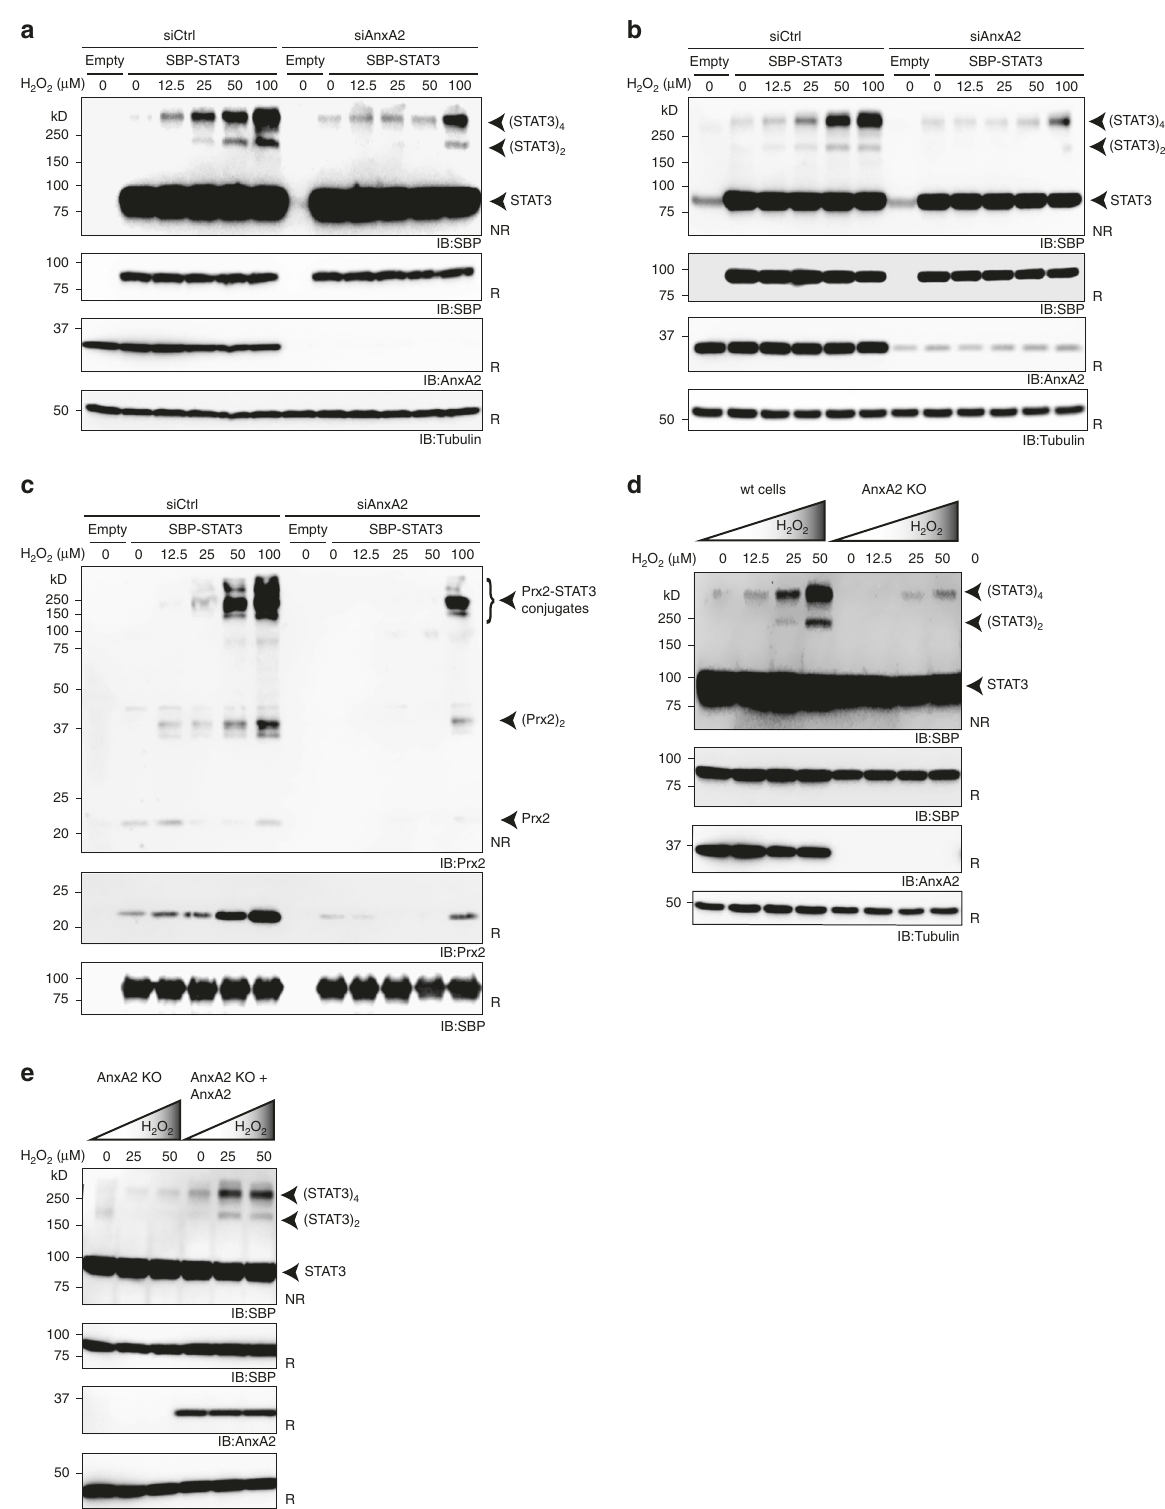
Fig. 4 STAT3 oxidation depends on AnxA2. a H 2 O 2 -induced STAT3 oxidation is diminished upon depletion of AnxA2 in HEK293 MSR cells. The formation of covalent (disul fi de-linked) STAT3 dimers and tetramers in response to increasing concentrations of exogenously applied H 2 O 2 is visualized by immunoblotting on non-reducing SDS-PAGE. b The same experiment as in a , performed in U2OS cells. c The formation of Prx2-STAT3 disul fi de exchange intermediates, representing the transfer of oxidizing equivalents from Prx2 to STAT3, is largely abolished upon depletion of AnxA2 in HEK293 MSR cells. d H 2 O 2 -induced STAT3 oxidation is largely abolished upon deletion of AnxA2 (AnxA2 KO) in HEK293 MSR cells. e Re-expression of ectopic AnxA2 in AnxA2 KO cells recovers H 2 O 2 -induced STAT3 oxidation. All immunoblots shown in this fi gure are representative of n = 3 independent experiments. IB immunoblot; NR/R Non-reducing/Reducing gel electrophoresis. All source data for this fi gure are provided as a Source data fi